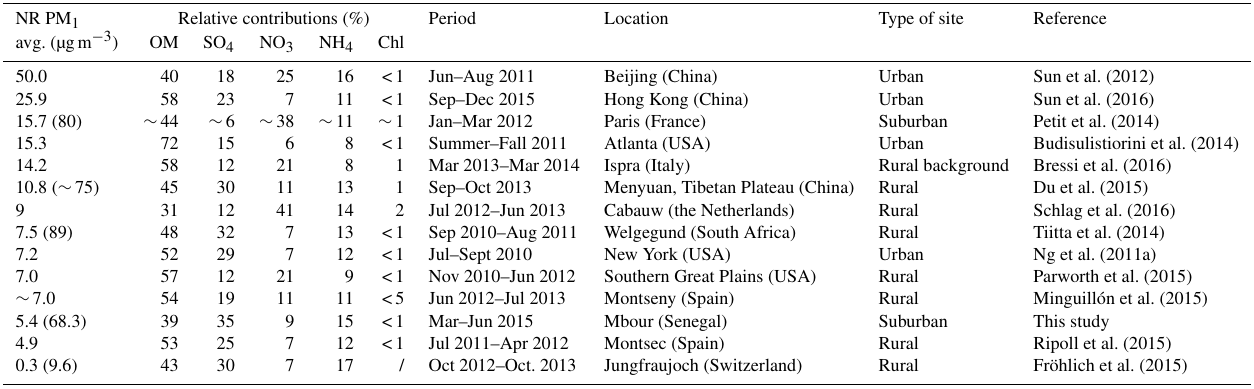
Table 1. Averaged NR PM 1 concentrations (in µgm − 3 ) – with maximum in parentheses when available – and respective contributions of NR compounds for this study compared to other ACSM campaigns from different locations.